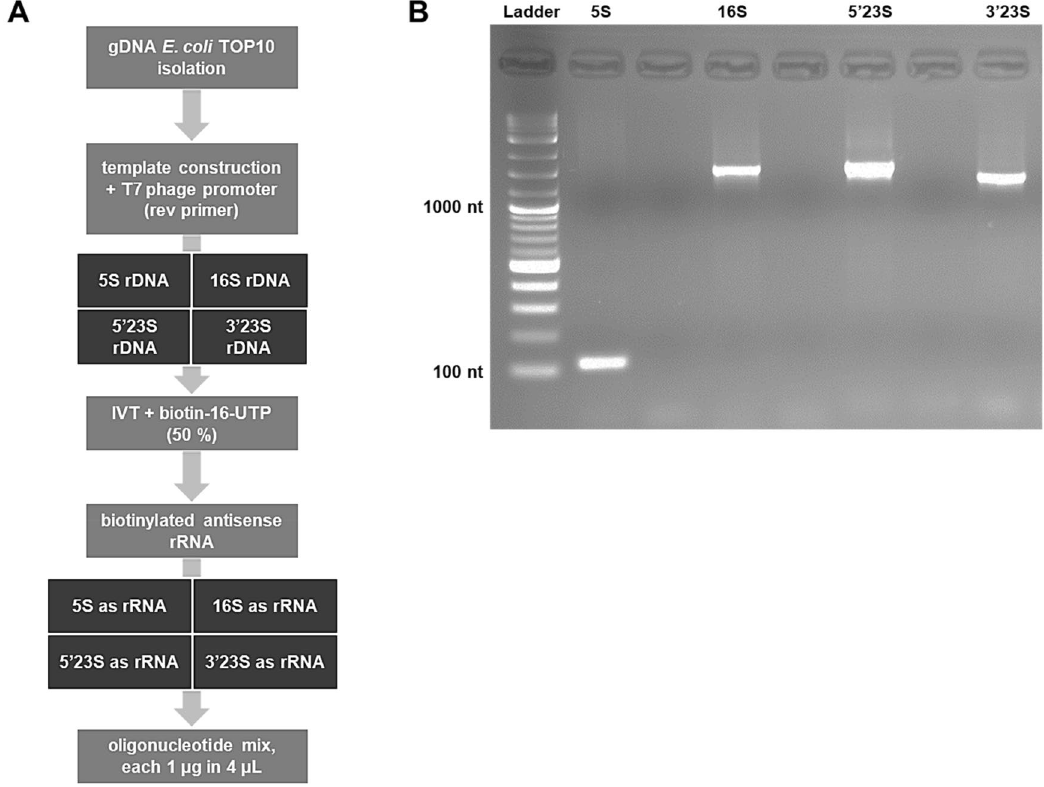
Figure 1. Construction of biotinylated antisense rRNA oligonucleotides. ( A ) Workflow for the construction of biotinylated antisense rRNA oligonucleotides. ( B ) Agarose-gel electrophoresis of biotinylated, full-length antisense rRNA oligonucleotides. Lanes have been labelled accordingly; ladder, 1 kb-Plus